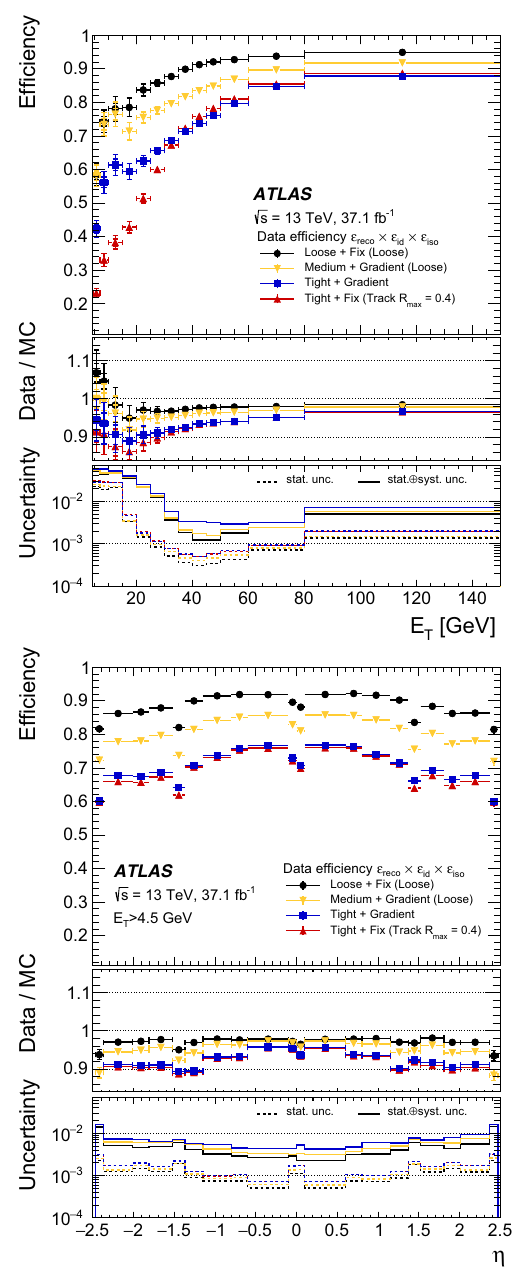
Fig. 16 The product of reconstruction, identification, and isolation efficiencies (cid:10) reco × (cid:10) id × (cid:10) iso for data from a Z → ee sample as a function of electron E T (top) and η for E T > 4 . 5 GeV (bottom), for the following operating points: “Loose + Fix (Loose)” (black circles), “Medium + Gradient (Loose)” (yellow upside-down trian- gles), “Tight + Gradient” (blue squares) and “Tight + Fix” (Track R max = 0 . 4) (red triangles). The inner uncertainties are statistical while the total uncertainties include both the statistical and systematic com- ponents. The lower panels show data-to-simulation ratios as well as the relative statistical and total uncertainties (statistical and systematic added in quadrature) applicable to both the data efficiencies and